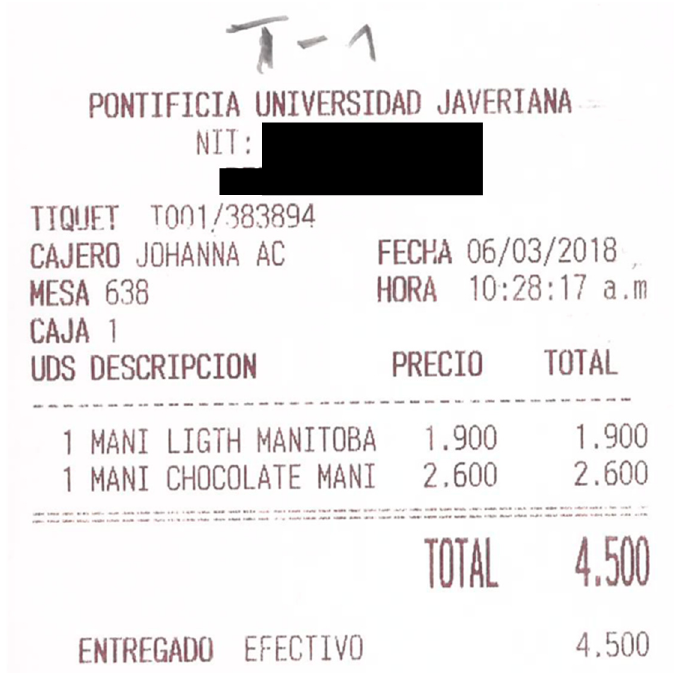
Figure A1. Example of an after-purchase printed receipt. The T on top means that the customer